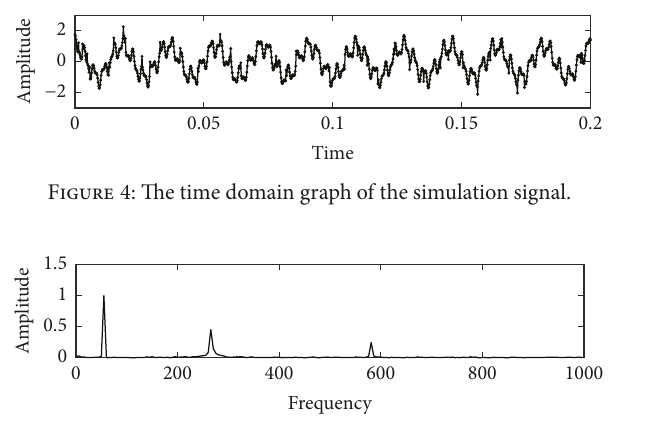
Figure 5: The corresponding spectrum graph of the simulation signal.